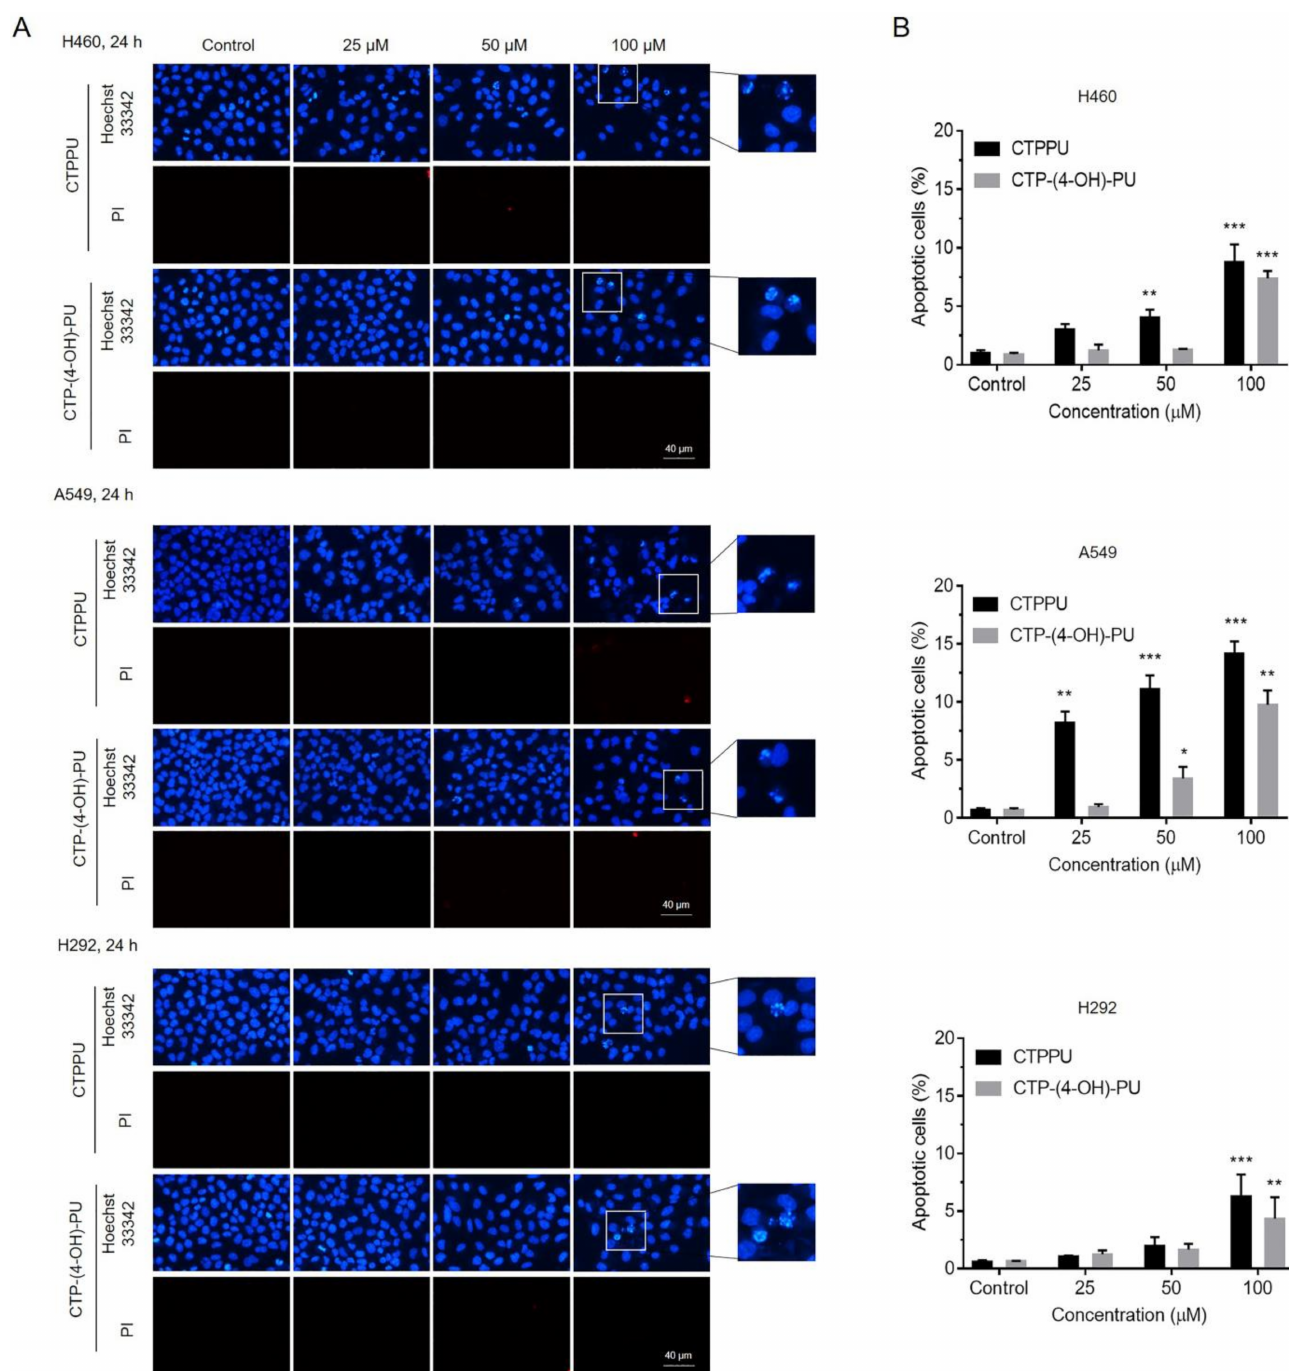
Figure 3. Effects of N,N (cid:48) -substituted phenylurea derivatives treatment on apoptosis-related mor- phological changes in NSCLC cells. ( A ) Morphological changes visualized by fluorescence mi- croscopy after Hoechst 33342/PI staining. NSCLC cell lines (H460, A549 and H292) were treated with CTPPU or CTP-(4-OH)-PU, stained with Hoechst 33342 and PI at 24 h. All images were captured at 400 × magnification. Scale bars, 40 µ m. ( B ) The percentages of apoptotic cells were counted in three independent random areas. The results are presented as mean ± SD, and all samples were measured independently in triplicate. Error bars are standard deviations. Significant differences are indicated as * p < 0.05, ** p < 0.01 and *** p < 0.001 compared with the